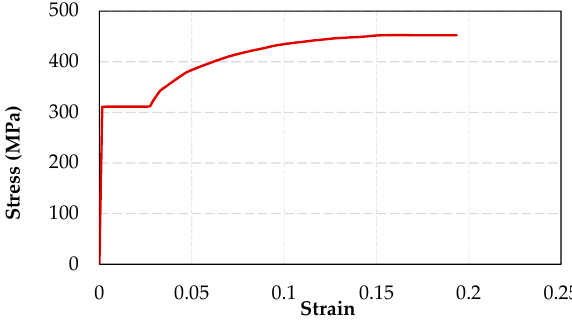
Figure 10. Axial stress-strain relationship assumed for steel bars.